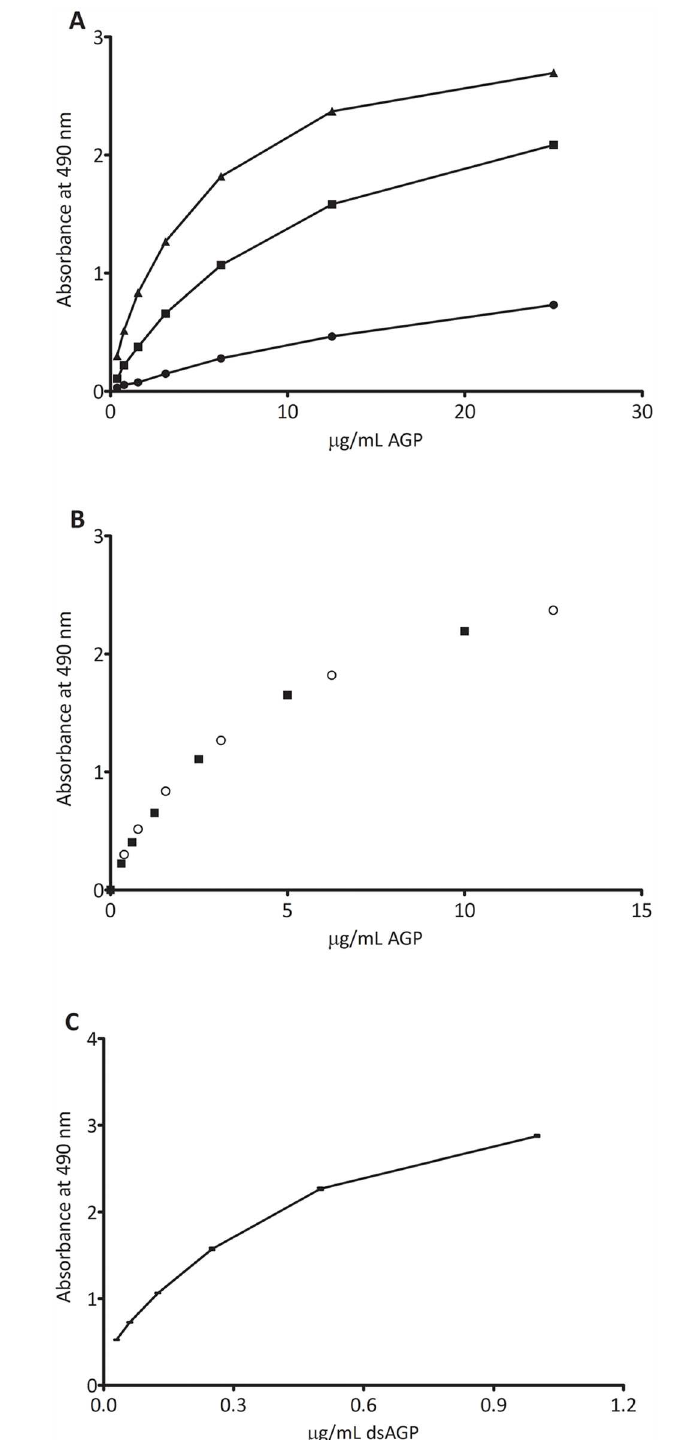
Fig 3. A . Bindingof different concentrations of purifiedAGP from patient samples to S2 in the reverse S2 lectin ELISA. AGP purifiedfrom a patient with HCC (black triangles), AGP purifiedfrom a cirrhosis patient (black squares) and AGP purifiedfrom a normalsample (black circles). B. Comparisonof bindingof different concentrations of purifiedAGP from a HCC patient sample diluted in 1% BSA in PBS (circles) and diluted in normalserum (black squares). C. Bindingof different concentrations of dsAGP to S2 in the reverse S2 lectin ELISA assay.